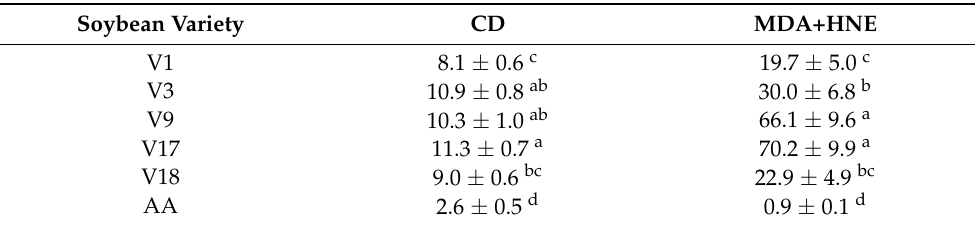
Table 3. Inhibitory activity (IC 50 , µ g mL − 1 ) of selected soybean digests (V1, V3, V9, V17, and